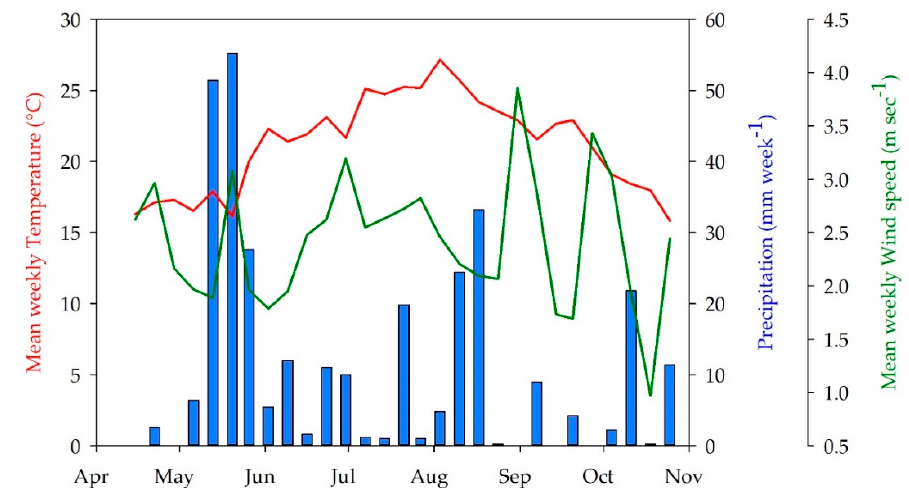
Figure 1. Weather data of the storage period. The red line represents the mean weekly temperature; blue bars are the cumulative weekly precipitation; the green line is the mean weekly wind speed.